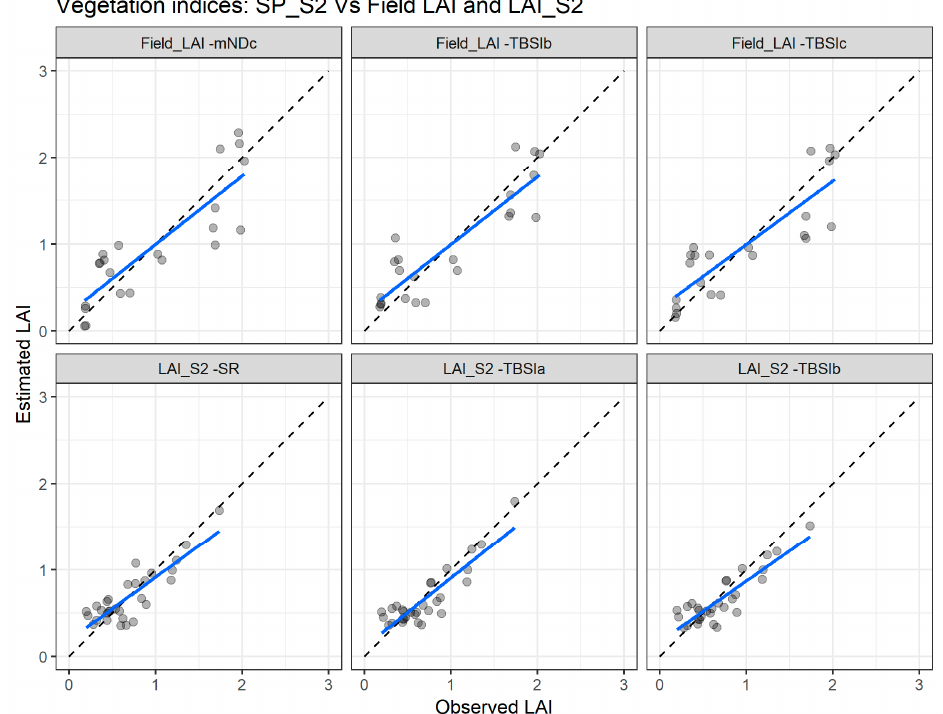
Figure 8. Comparisons of the measured and estimated LAI with the best performing vegetation indices using the Sentinel-2 spectral data (SP_S2) with the field leaf area index (Field_LAI) and with Sentinel-2 leaf area index product (LAI_S2). mNDc—modified difference index; TBSI—three band spectral index; SR—simple ratio. The blue line depicts the linear regression and the black dashed line the linear regression through origin.